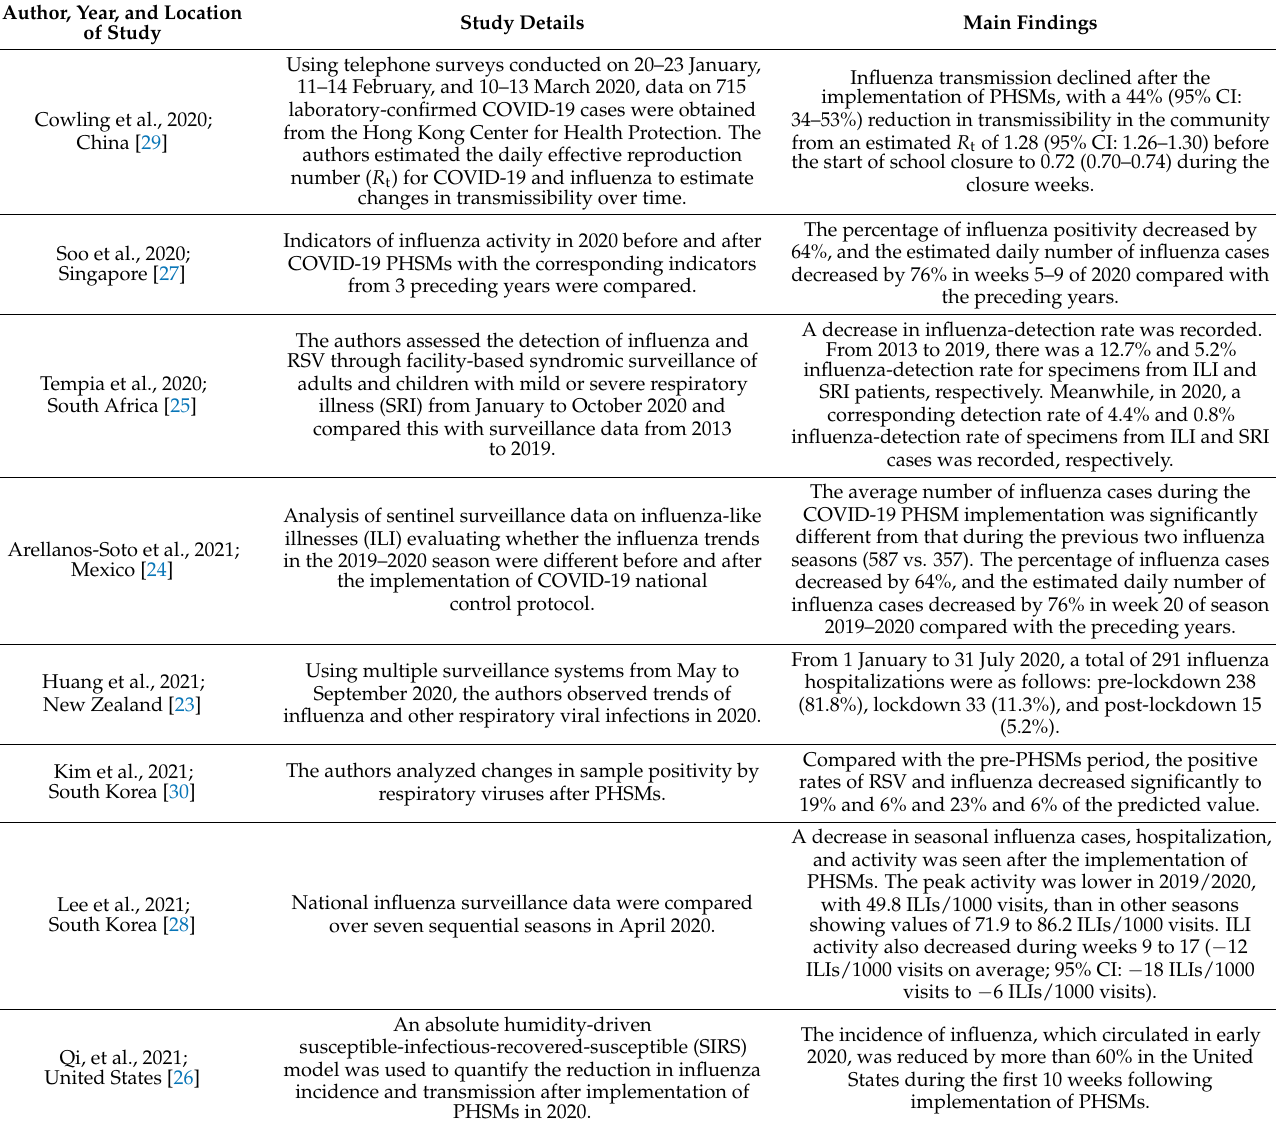
Table 1. Summary of influenza-related articles included in the systematic literature